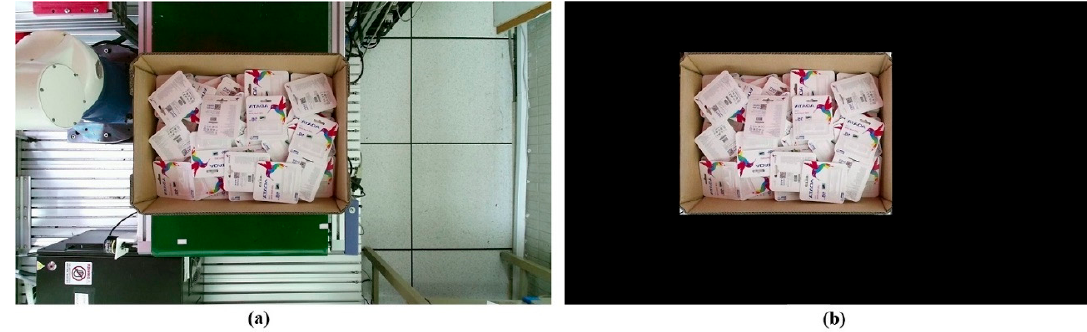
Figure 22. Image preprocessing to remove unnecessary information—( a ) the original RGB image captured by the camera; ( b ) the result after removing the unnecessary information.